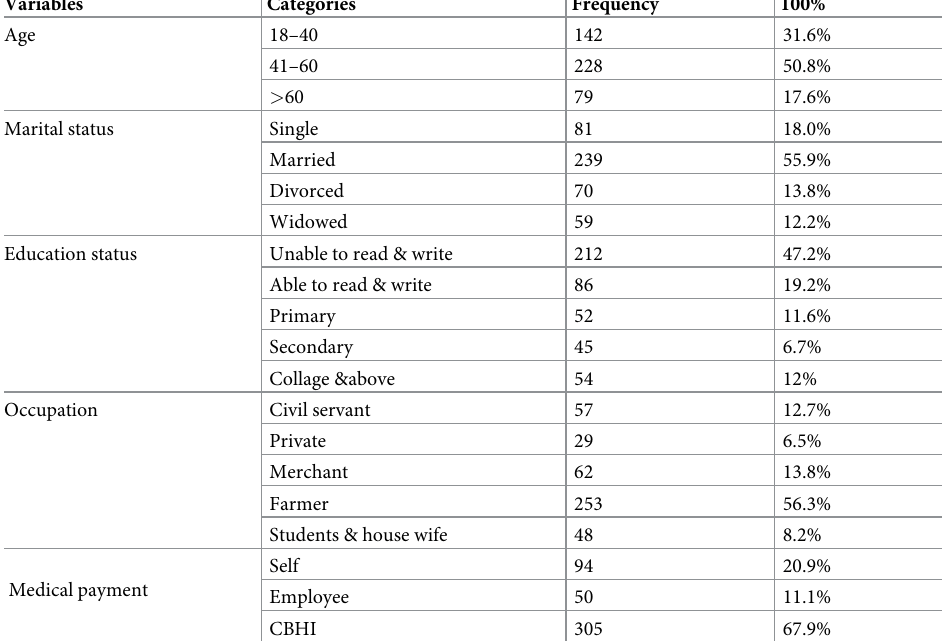
Table 3. Sociodemographic characteristics of adult cancer patients receiving cancer treatment at oncology unit in Amhara region, Ethiopia, 2022 (N =